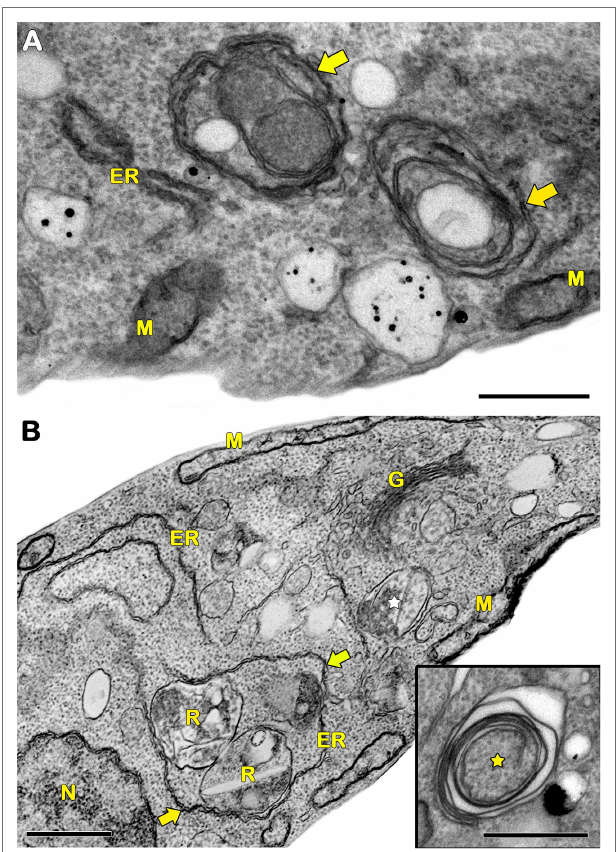
FIGURE 3 | Transmission electron microscopy analysis of ER surrounding organelles in Trypanosoma cruzi . (A,B) Endoplasmic reticulum (ER) profiles is recurrently observed in close contact with a great variety of organelles (arrows) in treated parasites. The treatment with drugs also induces the appearance of concentric membrane structures (i.e., myelin-like structures) and the formation of autophagosomes (star). M, mitochondrion; N, nucleus; G, Golgi; and R, reservosome. Bars = 0.5 μ m.